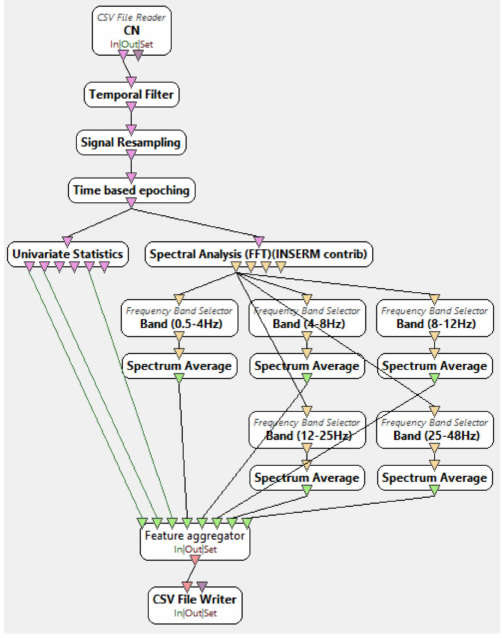
Figure 1. OpenViBE Xml diagram of signal processing and feature extraction.